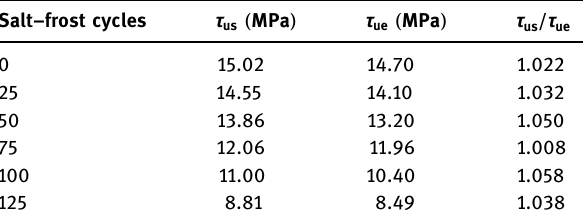
Table 3: Comparison of calculation results ( τ us ) and experiment results